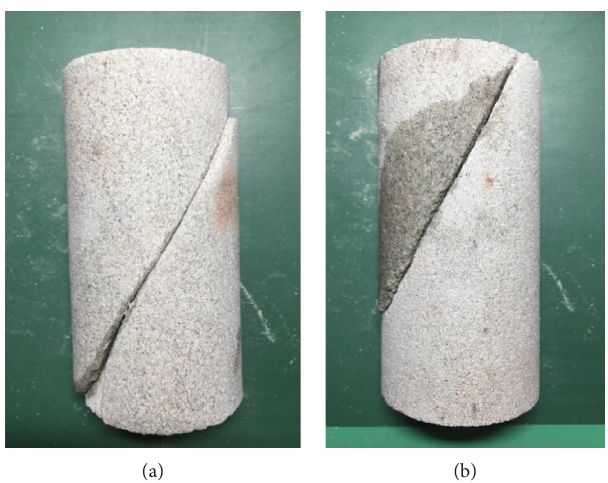
Figure 9: Complete sandstone destruction pictures. (a) 0-1. (b)